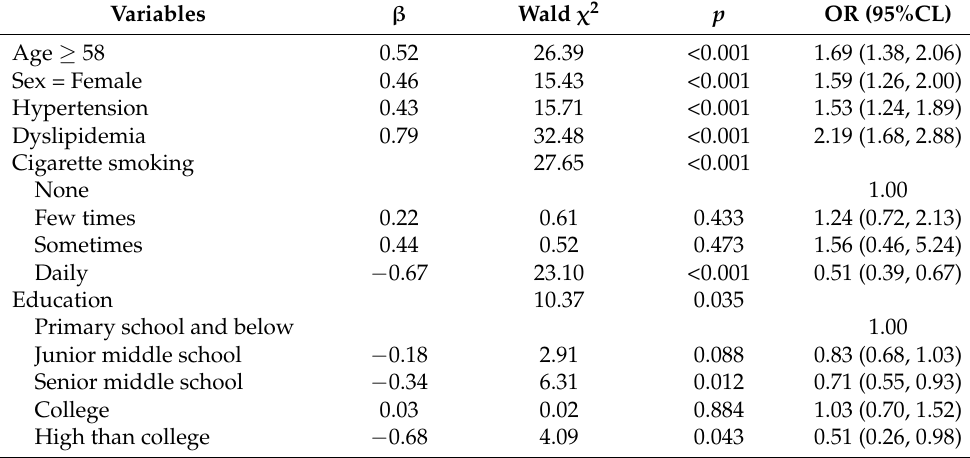
Table 2. Logistic regression showing predictors of normal weight central